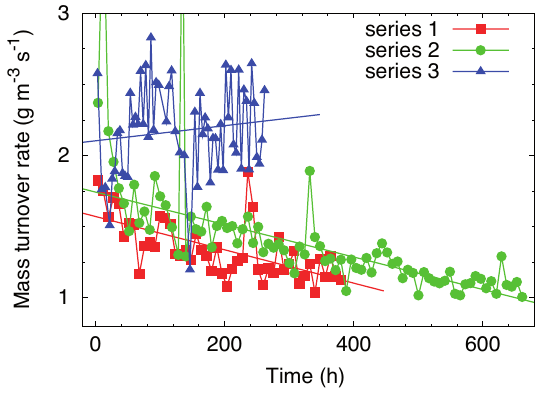
Fig. 8. Volumetric turnover rate due to ice sublimation and de- position. Symbols show the measured data, while lines obtained by linear regression indicate the trend. The average daily turnover amounts to 121, 130, and 190kg m − 3 d − 1 for Series 1, 2, and 3, re- spectively, corresponding to 47, 43, and 61% of the total ice